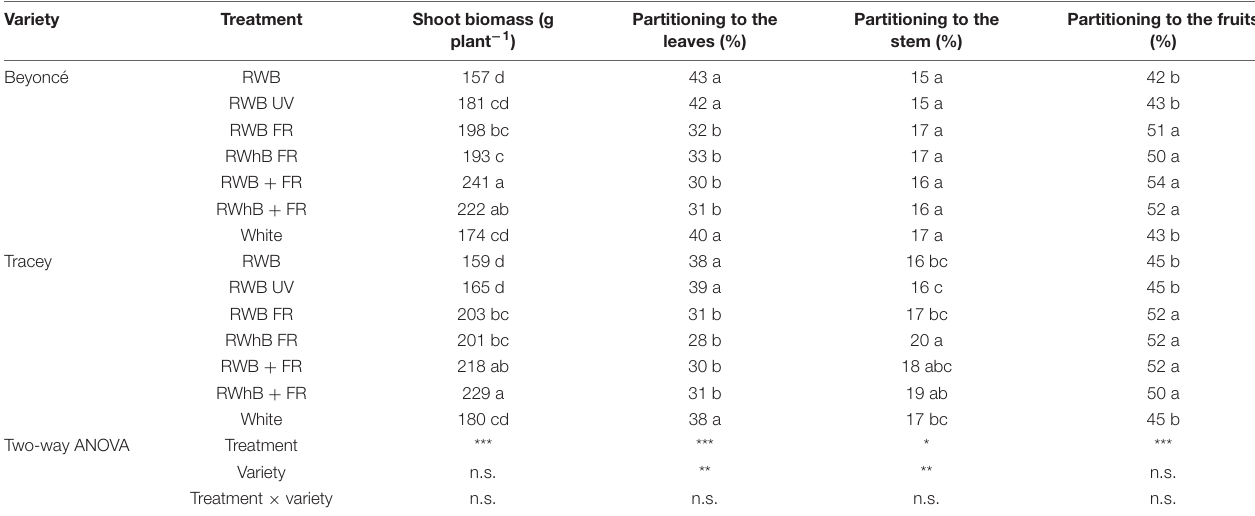
TABLE 4 | Effects of spectral composition on assimilate partitioning of